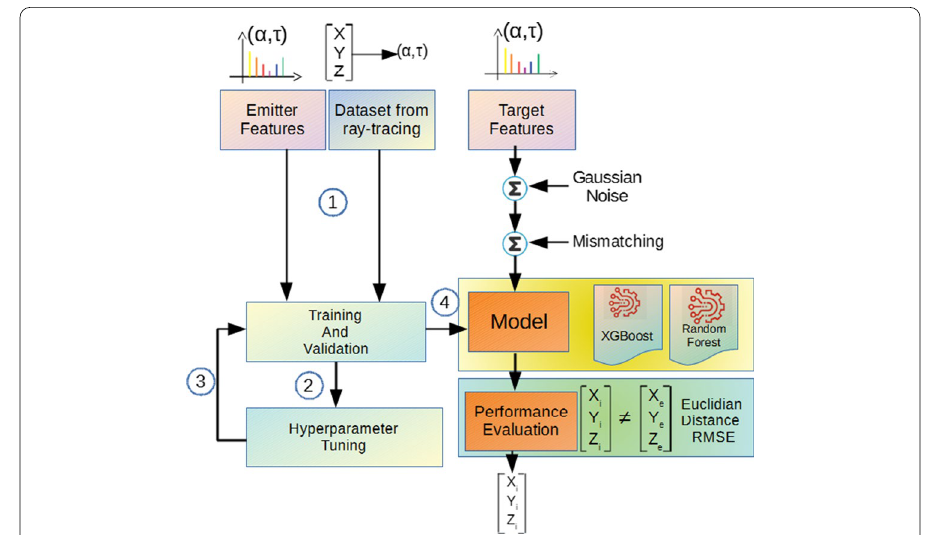
Fig. 1 Overview of the proposed